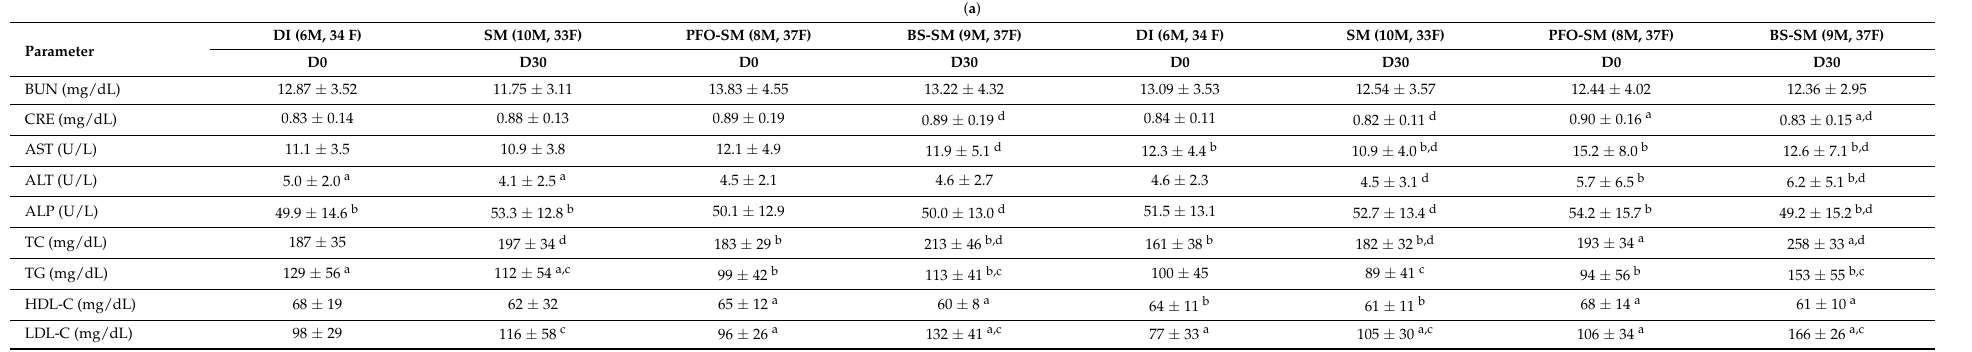
Table 6. ( a ) Biochemical marker values in the serum of subjects who consumed drinks for 30 days. Data are expressed as values of mean ± SD. Accordingly, a p values of <0.05 were considered significant when comparisons were made with baseline (D0) data of the same group using parametric paired Student’s t -test; b p values of <0.05 were considered significant when comparisons were made with baseline (D0) data of the same group using non-parametric Wilcoxon test; c p < 0.05 were considered significant when comparisons were made between changes in the four groups using the parametric one-way ANOVA followed by post hoc Tukey’s HSD or Dunnett T3 tests; d p < 0.05 were considered significant when comparisons were made between changes in the four groups using the non-parametric Kruskal-Wallis test. ( b ) Biochemical marker values in the serum of subjects who consumed drinks for 30 days. Data are expressed as values of mean ± SD. Accordingly, e p values of <0.05 were considered significant when comparisons were made between male and female subjects in the same group and at the same time using a parametric independent sample of the Student’s t -test; f p values of <0.05 were considered significant when comparisons were made between male and female subjects in the same group and at the same time using non-parametric Mann-Whitney U test g